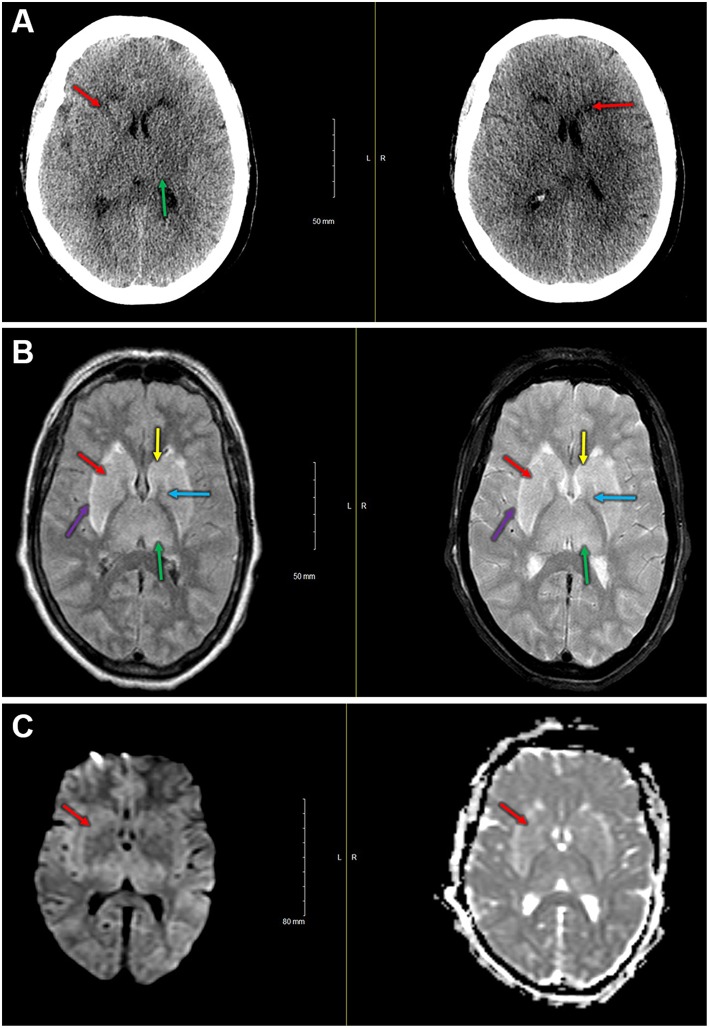
(A) Immediate postoperative non-contrast head CT shows bilateral symmetric hypoattenuation adjacent to the basal ganglia (red arrows). Less pronounced findings throughout the thalamus (green arrow). (B) Left—fluid attenuation inversion recovery imaging shows bilateral hyperintense signals in the basal ganglia (caudate [yellow] and putamen [red], globus pallidus [blue]) and in the thalami [green]). Note the hyperintense signal at the external capsule [purple], just lateral to the putamina. Right—T2 fat suppressed imaging demonstrating hyperintense signal in the basal ganglia (caudate [yellow] and putamen [red], globus pallidus [blue]) and in the thalami [green]). Hyperintense signal also present in the external capsules [purple]. (C) Diffusion-weighted imaging (left) and apparent diffusion coefficient (right) demonstrate slightly elevated signal on diffusion-weighted imaging with small areas of hypointense signal on the apparent diffusion coefficient in the basal ganglia (i.e., right anterior putamen, red arrow).